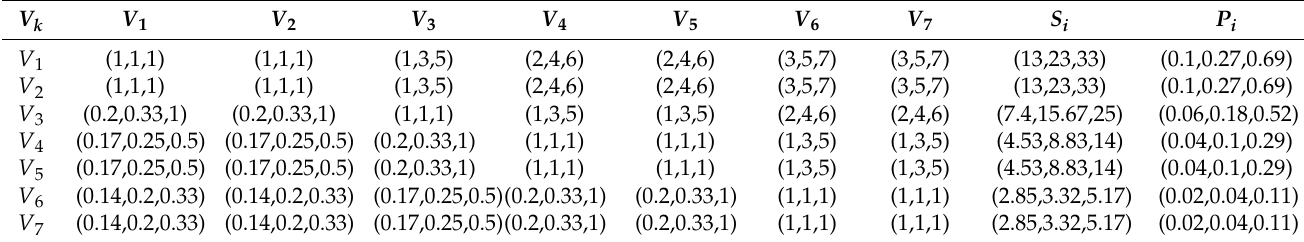
Table 4. Fuzzy judgment matrix and fuzzy synthetic extent of vulnerability indicators.